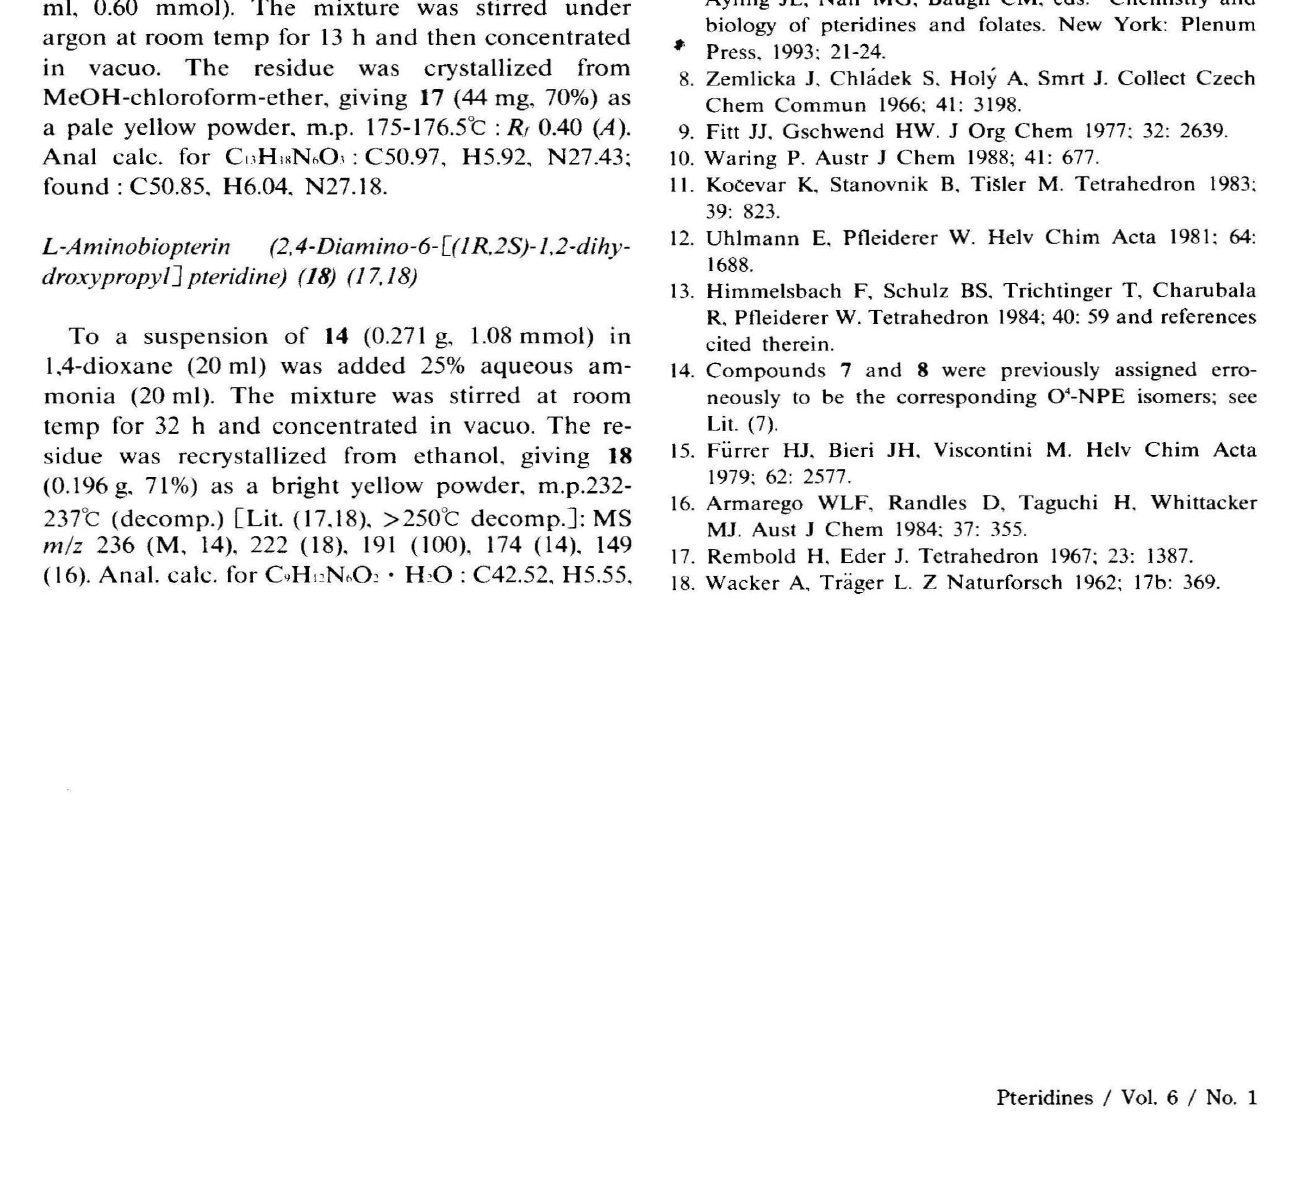
Di-O-acetyl-04-(p-nitrophenethyl)-L-biopterin (16) A solution of 13 (20 mg) in dry methanol (2 ml) was stirred under argon at room temp for 26 hand then concentrated in vacuo. The residue was chro matographed in a column of silica gel with I : 19 MeOH-CHCb. giving a I : 3 mixture of 15 and 16 (15 mg, ca. 88% yield) as a pale yellow powder: Rr 0.39 for 15, 0.38 for 16 (A). The mixture was inse parable even by repeated chromatography.